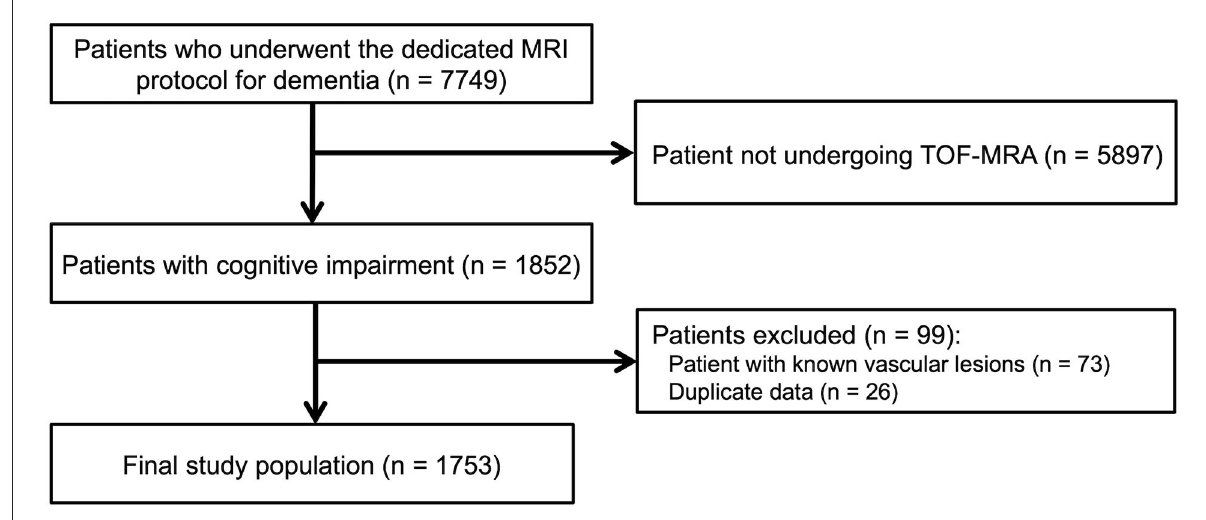
FIGURE1 Flow diagram of patient inclusion. TOF-MRA, time-of-flight magnetic resonance angiography.